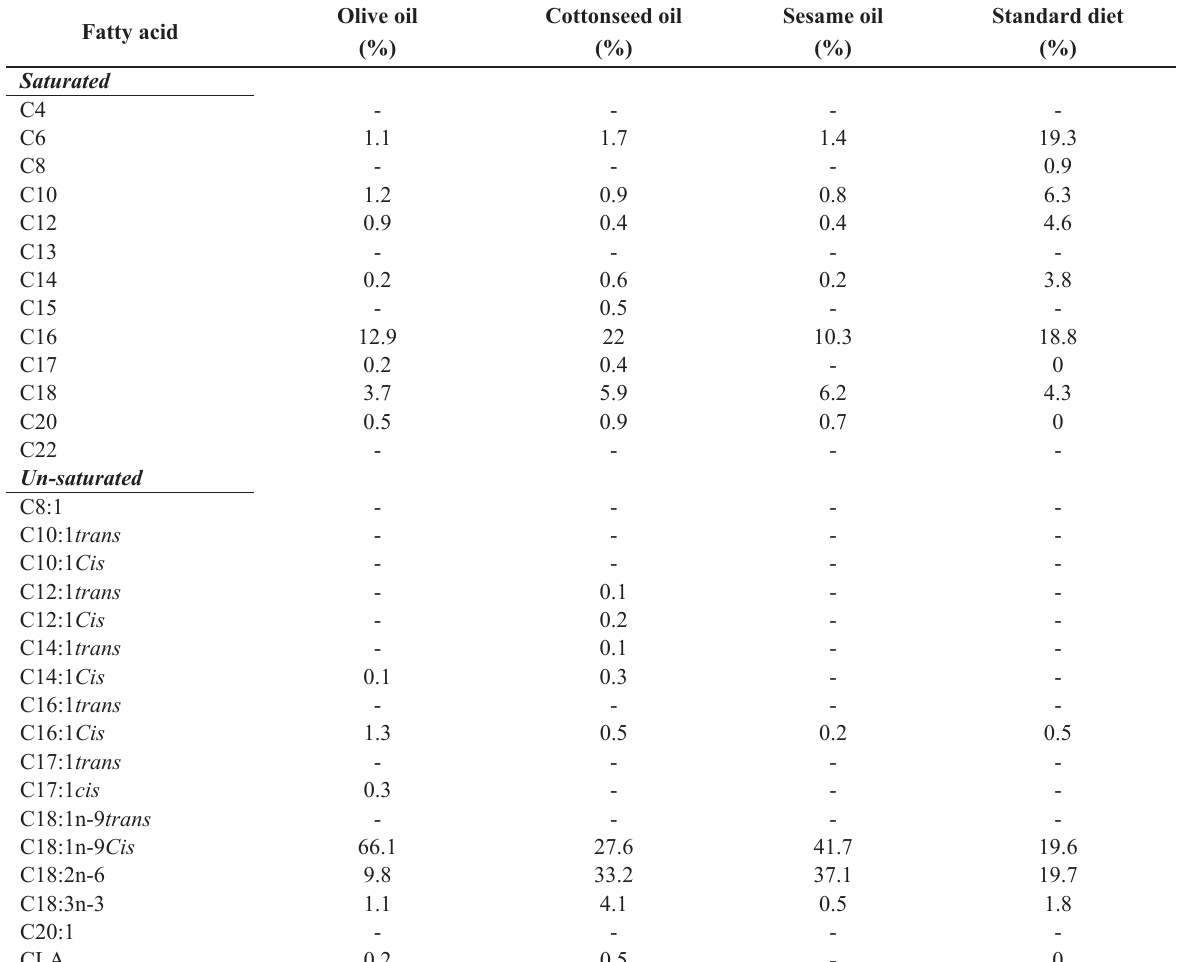
TABLE I Fatty acid composition of the oils and standard diet. Olive